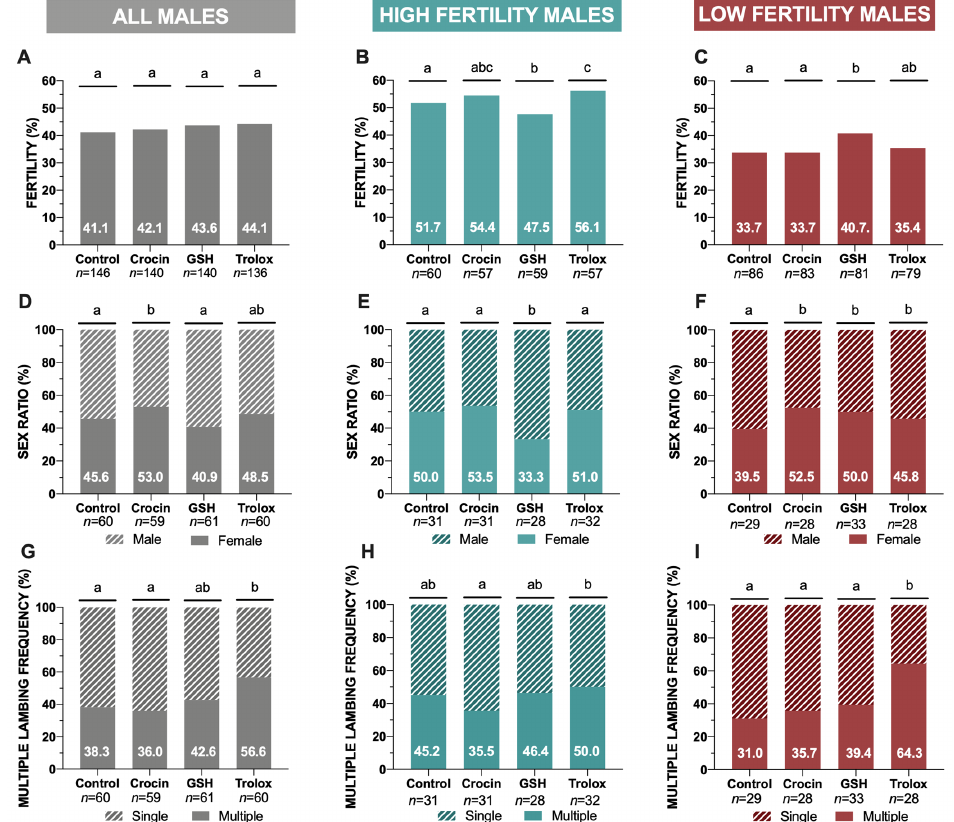
Figure 1. Ram cryopreserved sperm fertility trials in the four experimental groups (control: without antioxidants, 1 mM GSH, 1 mM crocin and 1 mM trolox supplementation). ( A ) Global fertility (lambed ewes/inseminated ewes, %) including all analyzed males; ( B ) Fertility (%) in high fertility males (HFM); ( C ) Fertility (%) in low fertility males (LFM); ( D ) Global sex ratio results (females vs. males frequency, %) including all analyzed males; ( E ) sex ratio analysis (lambed ewes/inseminated ewes) (%) in high fertility males (HFM); ( F ) sex ratio analysis (lambed ewes/inseminated ewes) (%) in low fertility males (LFM); ( G ) Lambing performance (multiple lambing frequency, %) considering all males; ( H ) Multiple lambing frequency (%) in high fertility males (HFM); ( I ) Multiple lambing frequency (%) in low fertility males (LFM). Significant differences ( p < 0.05) among experimental groups are represented with different lowercase letters. A total number of 562 inseminated females were analyzed were employed in the fertility trials.